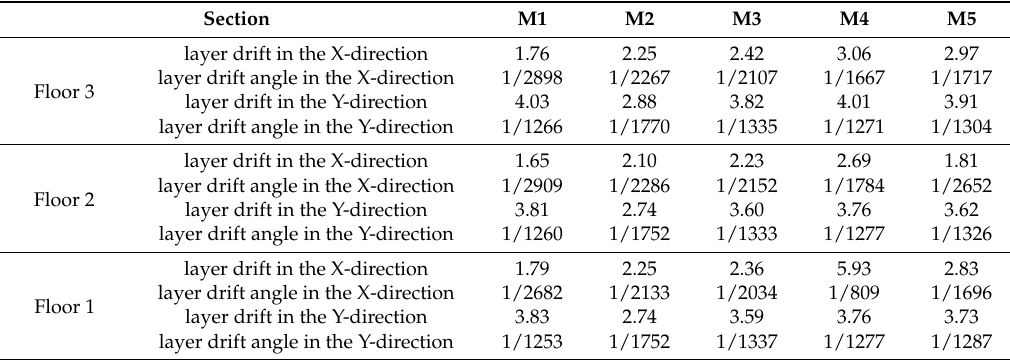
Table 13. Layer drift (mm) and drift angle (rad) under El-Centro